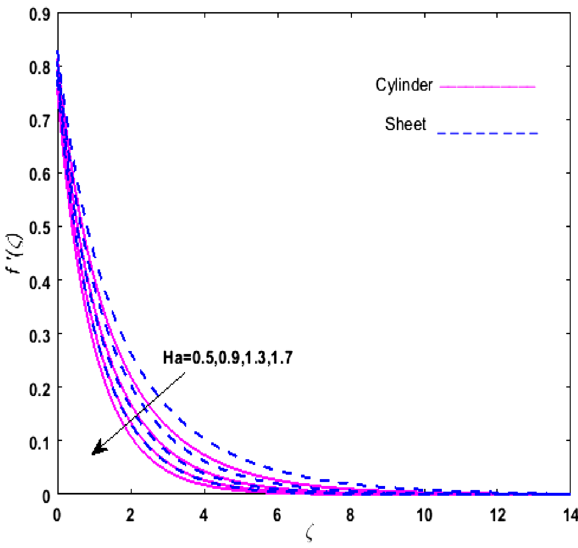
Figure 6. Upshot of Ha on f ′ (ζ) .